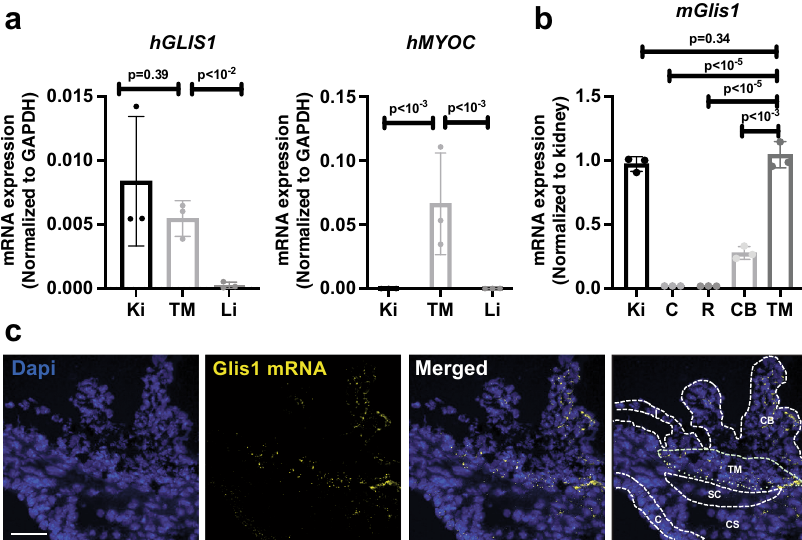
Fig. 3 GLIS1 is highly expressed in TM. a QPCR analysis of GLIS1 and MYOC mRNA expression in human TM tissue, kidney (Ki), and liver (Li) ( n = 3; technical replicates). Statistical analyses were performed with a two-tailed Student ’ s t test. Data are represented as means± SD. p Values are indicated above the bars. b Comparison of mouse GLIS1 RNA expression in several ocular tissues with that of kidney, a tissue in which GLIS1 is highly expressed ( n = 3; distinct samples). Statistical analyses were done with a two-tailed Student ’ s t test. Data are represented as means ± SD. p Values are indicated above the bars. c RNAscope in situ hybridization with eye sections from a 3-month-old WT mouse showed that GLIS1 mRNA (yellow speckles) expression was restricted to TM and CB. Dashed lines outline different cell compartments. Kidney (Ki), Cornea (C), Retina (R), Ciliary Body (CB), Trabecular Meshwork (TM), Corneal StromaI (CS), Iris (I), and Schlemm ’ s canal (SC). Scale bar = 50 μ